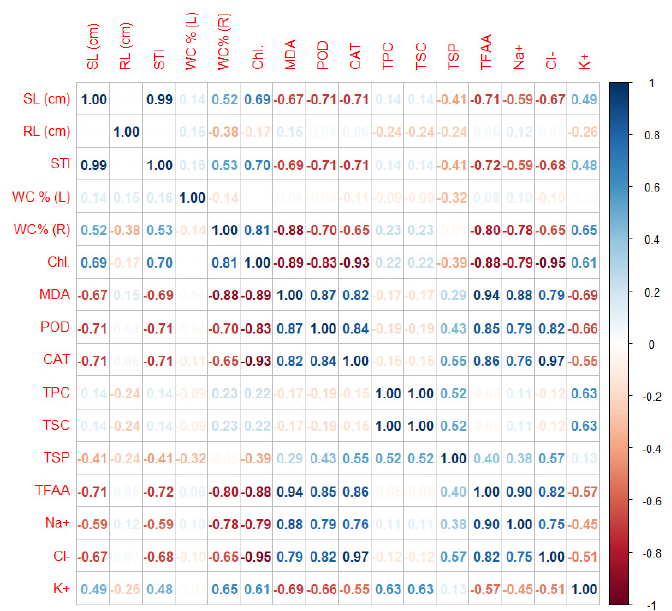
Figure 6. Pearson’s linear correlation for all measured biochemical parameters of Thymus serpyllum plants after five weeks of salt stress and sugar beet molasses treatments. The concentration of NaCl changes the activity of biochemical parameters. As NaCl increases, Chl, TPC and CAT are positively correlated with each other (Figure 8a). Increas- ing the concentration of NaCl may result in greater activity of MDA and STI (Figure 8b). Moreover, a higher increase in NaCl concentration affects the presence of TFAA (Figure